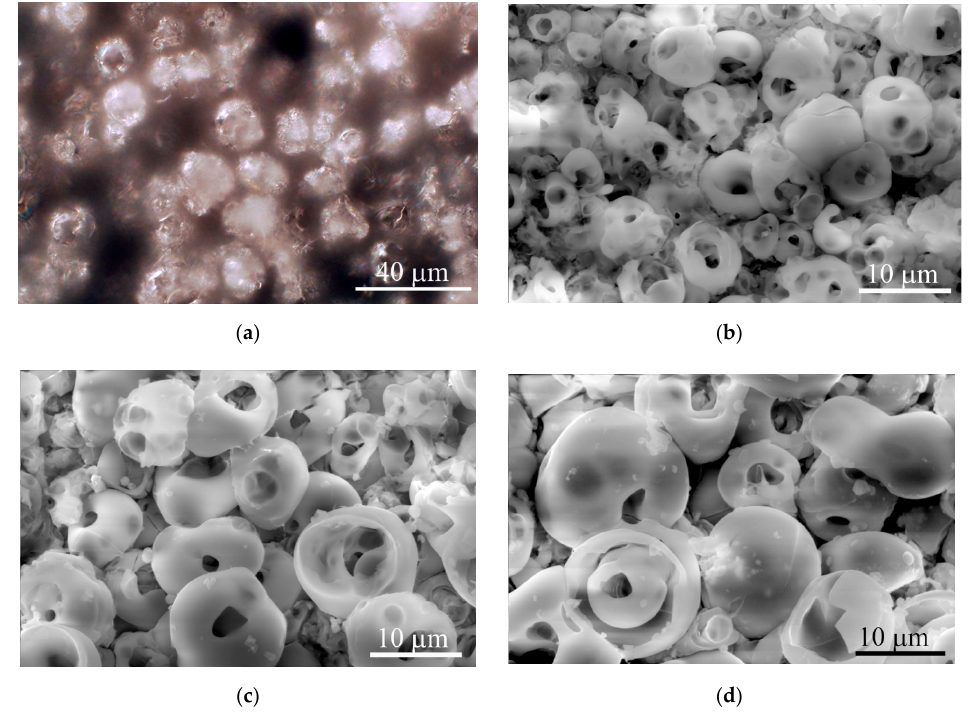
Figure 3. Optical microscopy ( a ) and SEM ( b )–( d ) images of typical topography of the microarc rough CaP coating on titanium substrates. ( a ) Reflected dark-field microscopy; ( b ) R a = 2.0 − 2.9 µm; ( c ) R a = 3.0 − 3.9 µm; ( d ) R a = 4.0 − 4.9 µm. Scale bars 10 and 40 µm. Magnification, × 1000 ( a ) and × 2500 ( b – d ).